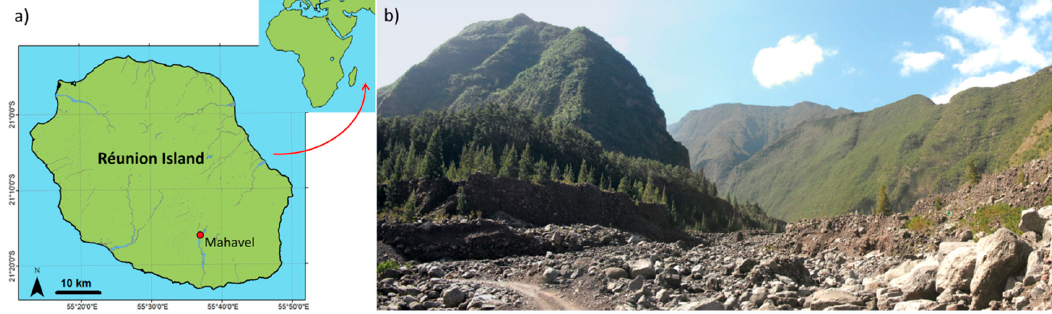
Figure 1. ( a ) Location map of the study area, the Mahavel landslide, on Reunion Island; ( b ) Photograph illustrating the variety of terrain and textures present in the study area.